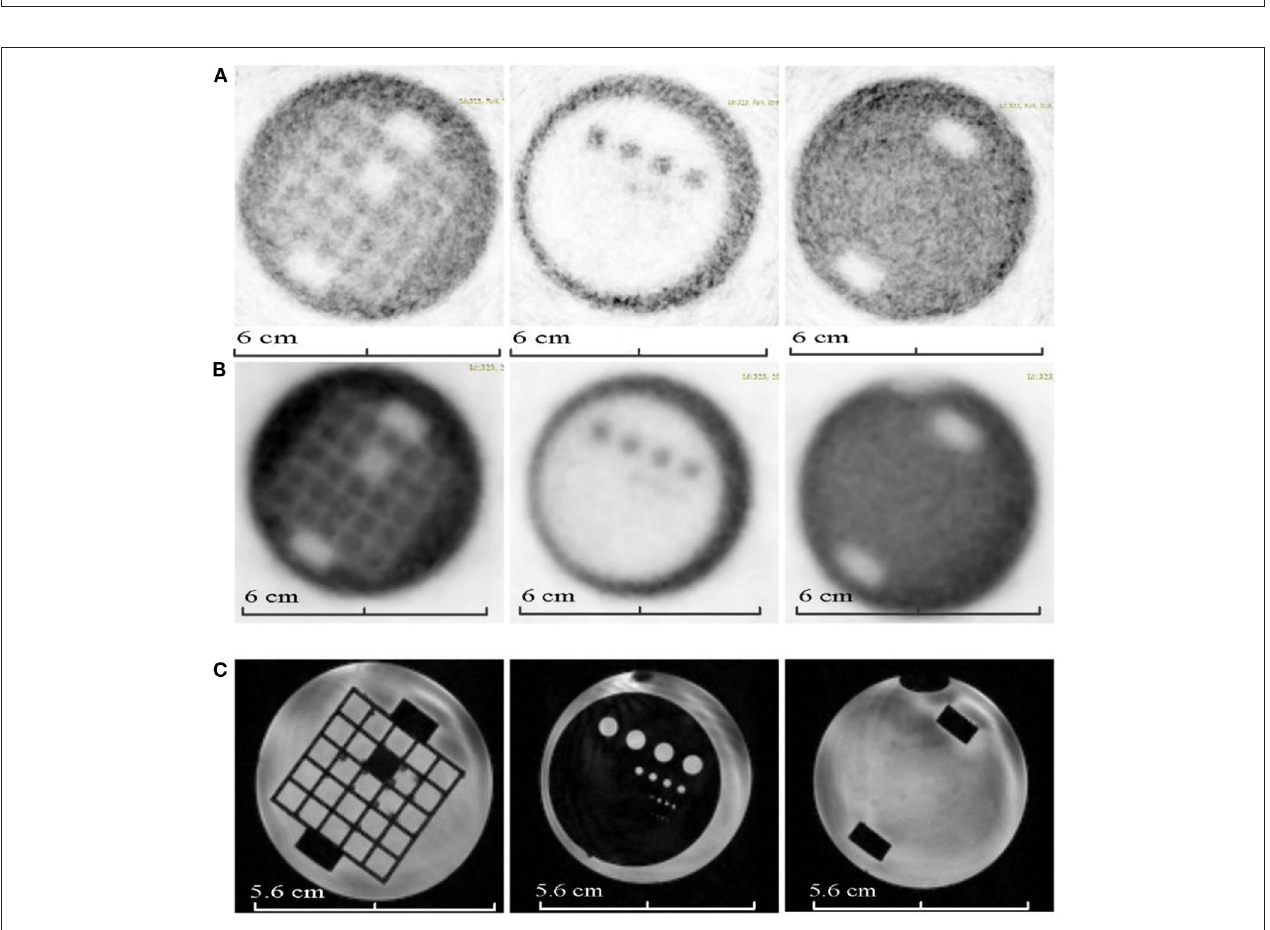
FIGURE 9 | PET and MRI images of the 3D-printed PET/MR phantom modules (from left to right, geometric distortion test module, high contrast resolution module, and uniformity module). (A) Shows the PET images of the phantom based on Tera-Tomo reconstruction algorithm. (B) Shows the PET images of the phantom based on OSEM-Fore reconstruction algorithm. (C) Shows the MRI images of the phantom. Phantom dimensions are marked in the